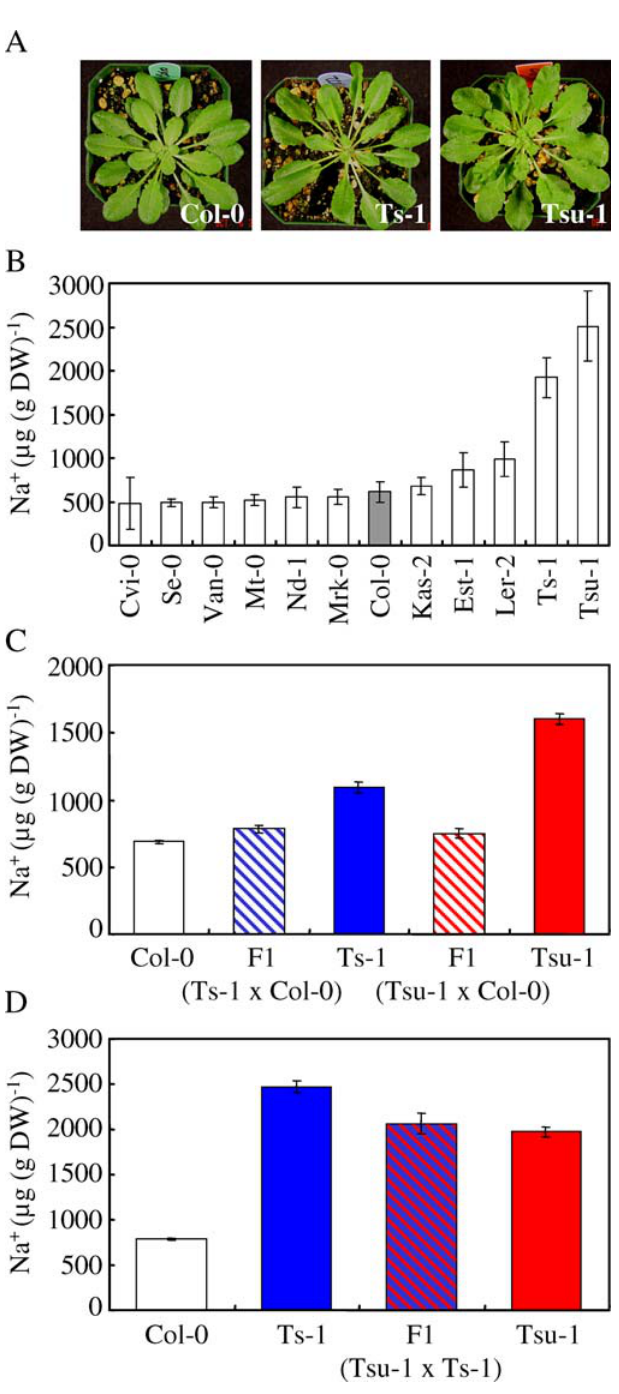
Figure 1. Genetic Analysis of the High Na þ Trait in Shoots of Arabidopsis thaliana Accessions Ts-1 and